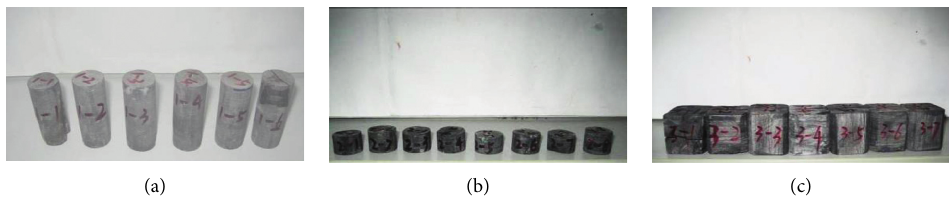
Figure 3: Rock samples used in the experiments. (a) Uniaxial compression test samples. (b) Splitting test samples. (c) Shear strength test samples.